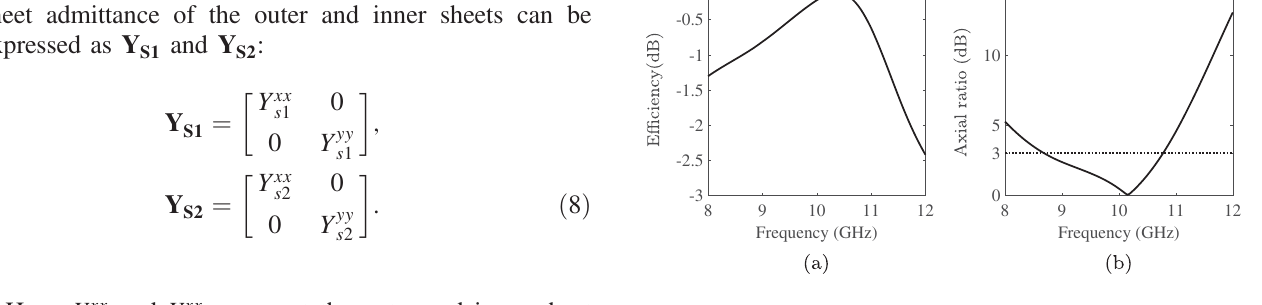
FIG. 3. Simulation results of (a) efficiency and (b) axial ratio of the designed